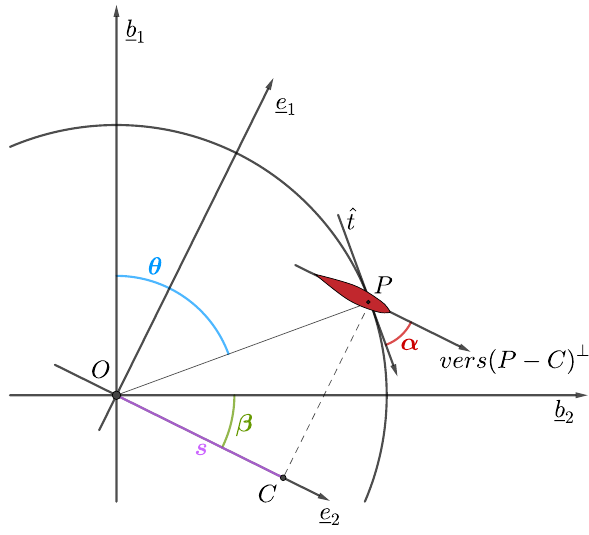
Figure 3. Kinematics of the